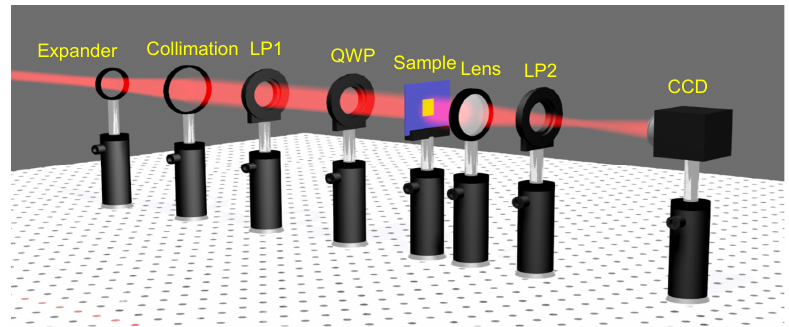
Fig. 4 | Experimental setup for polarized detection. Expander: concave lens with f= -75 mm. Collimation: convex lens with f= 200 mm. LP1 and LP2: linear polarizer. QWP: quarter wave plate. Sample: designed metasurface with effective size approximately 300  m  300  m. Lens: convex lens with f= 50.8 mm. CCD: charge-coupled device with pixel numbers 1024  1392.